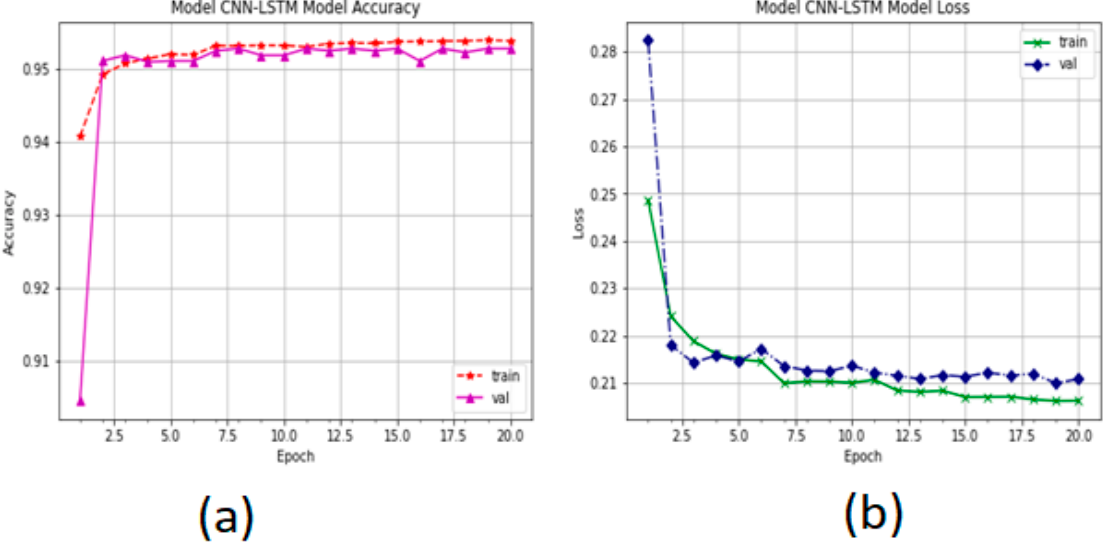
Figure 11. The performance of CNN-LSTM: ( a ) accuracy performance and ( b ) training loss and validation of the CNN-LSTM model.